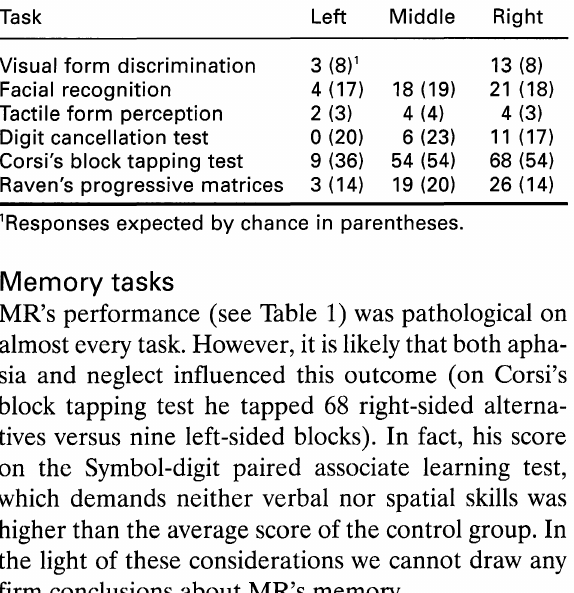
TABLE II. Position preference assessment: number of choices on the left, middle and right side Task Left Middle Right Visual form discrimination 3 (8)' 13 (8)